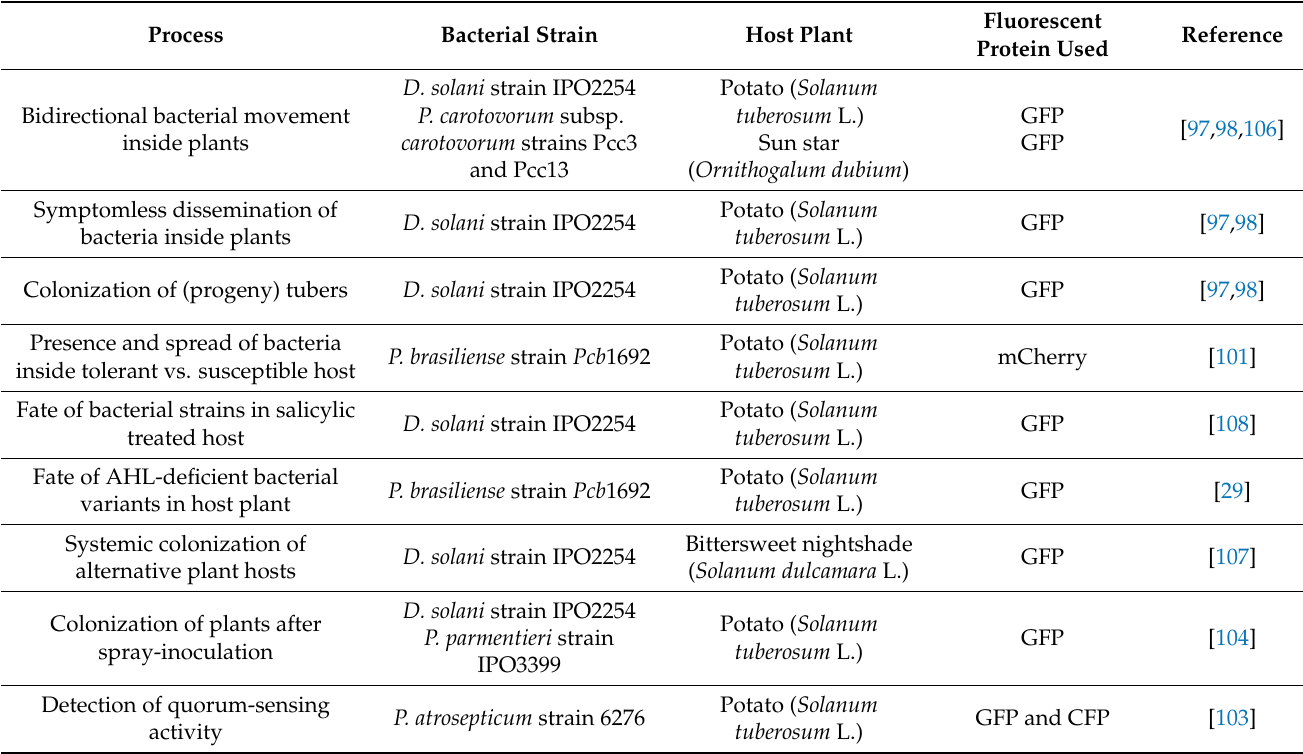
Table 2. The first described use of fluorescent proteins (FP) and FP-tagged strains to monitor the fate of SRP bacteria during interaction with plants.